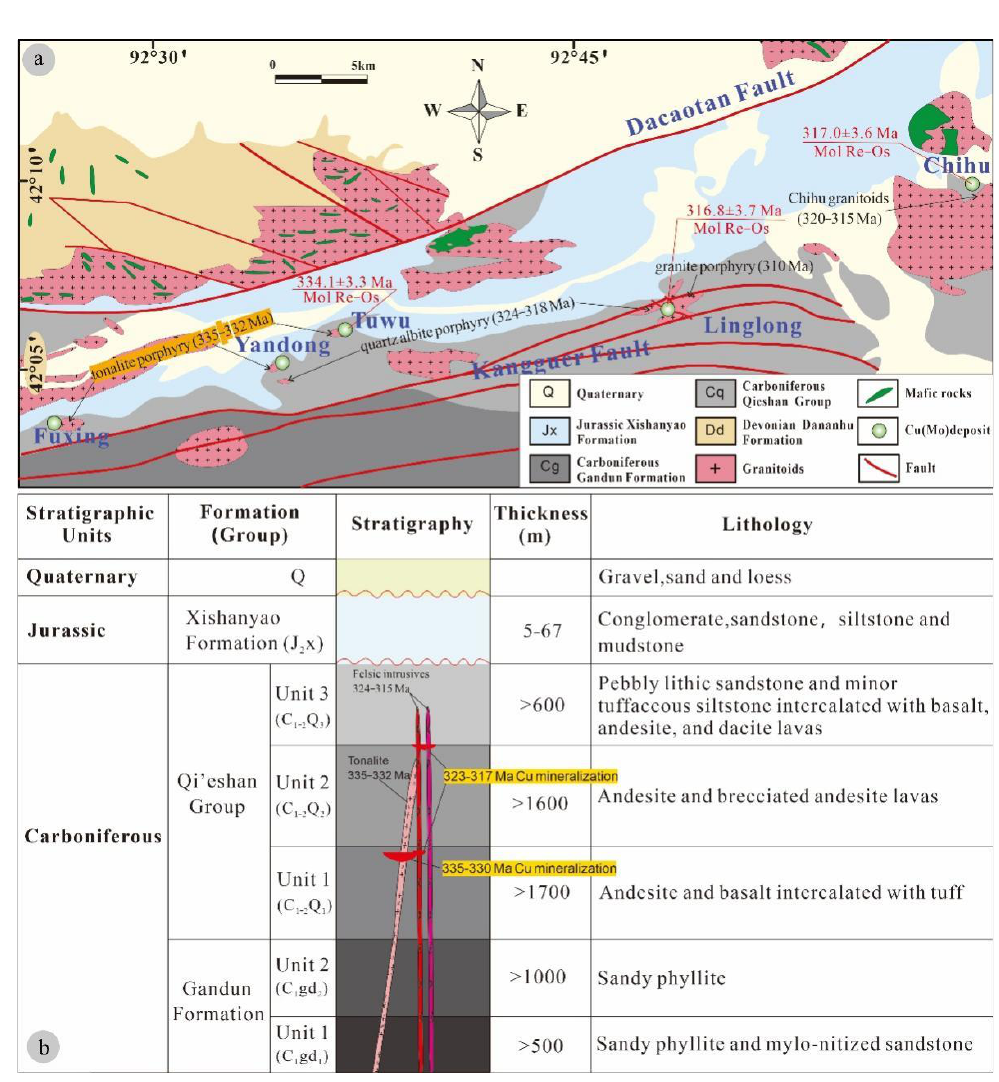
Figure 2. ( a ) Regional geology and distribution of porphyry Cu deposits in the Tuwu – Yandong belt, Eastern Tianshan (modified after [14]). ( b ) Stratigraphic column of the Tuwu – Yandong porphyry Cu belt (modified after [42]).